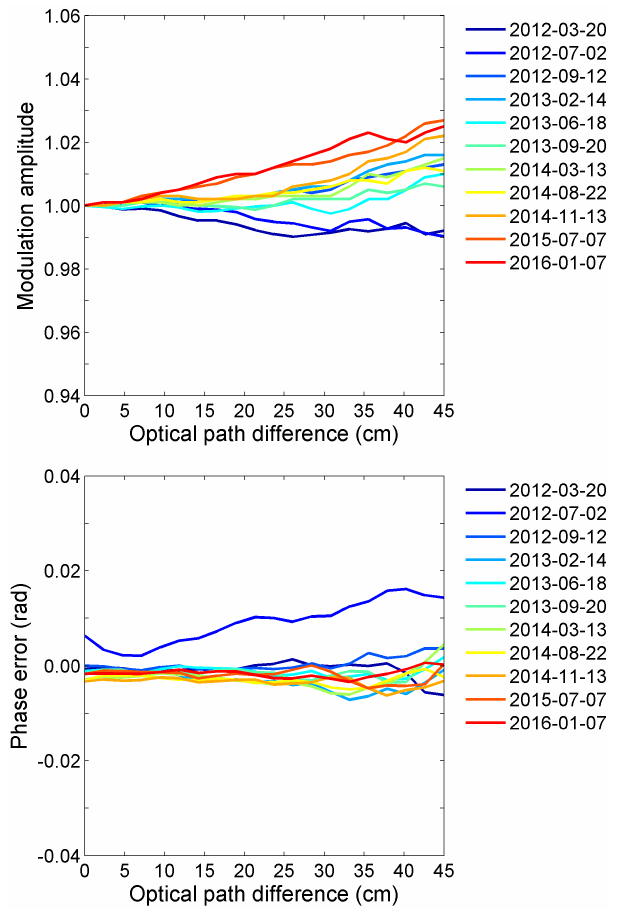
Figure 1. Time series of measurements of modulation efficiency: amplitude (upper panel) and phase errors (lower panel) are shown as a function of optical path difference.